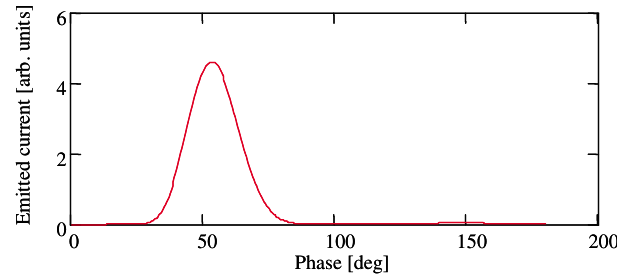
FIG. 7. (Color) Expected current emission profile, FE cathode, for the field shown in Fig.